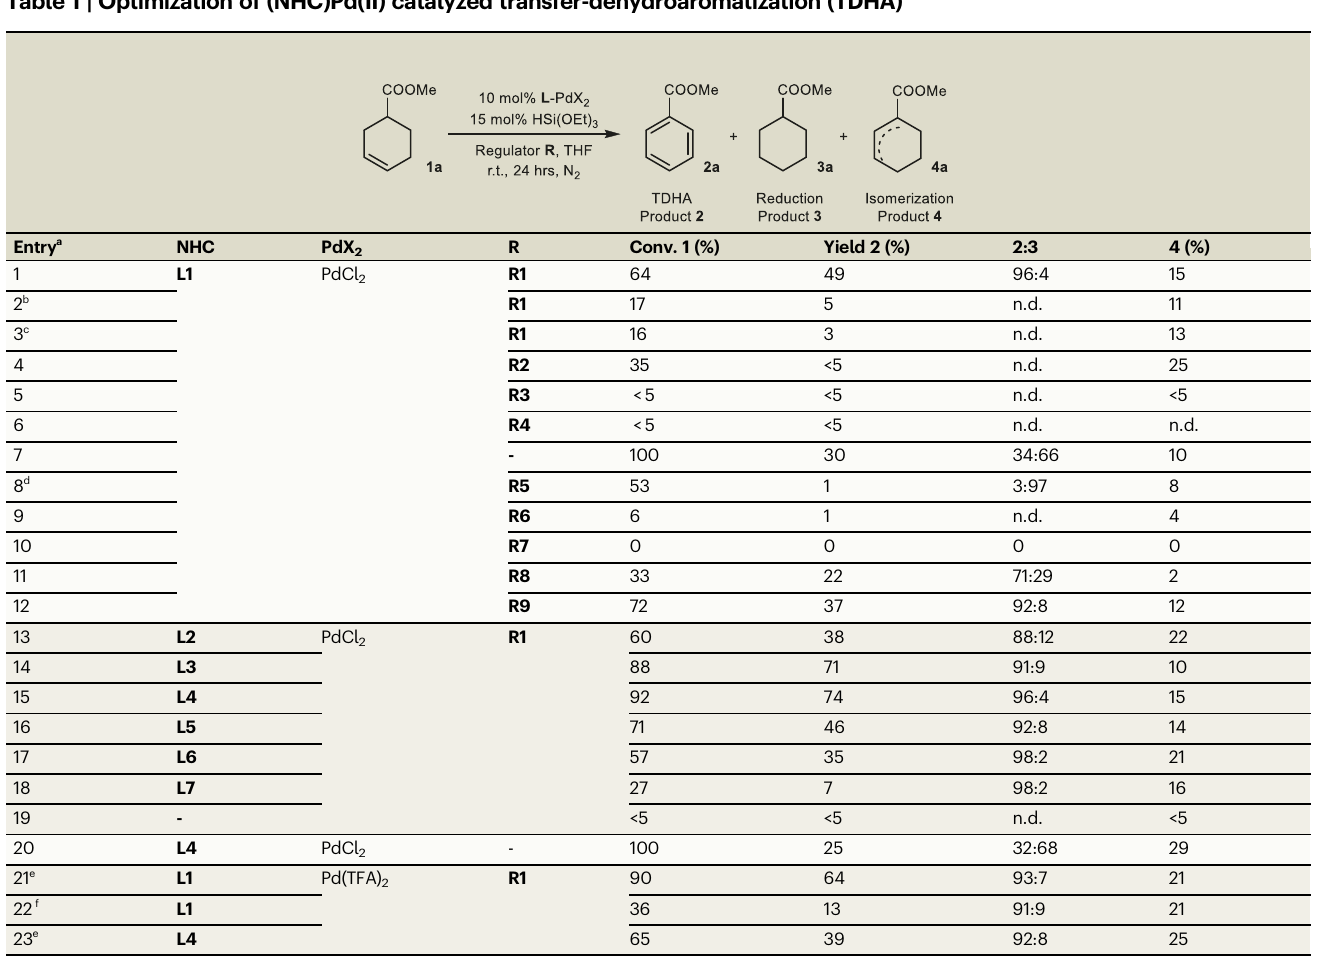
Table 1 | Optimization of (NHC)Pd(II) catalyzed transfer-dehydroaromatization